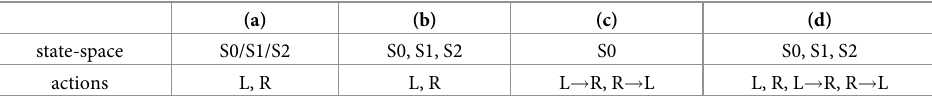
Table 1. Four hypotheses about state-space and action representations. (a) The state-space constitutes a single stage (outcomes such as food pellets are not shown here as states), and ‘L’ and ‘R’ are the only possible actions that the subject considers taking. (b) The state-space matches the correct state-space of the task, and the actions are ‘L’ and ‘R’. (c) The state-space only consists of state S0, and actions are ‘L ! R’ and ‘R ! L’. Note that single actions ‘R’ and ‘L’ are not included. (d) The state-space represents the two stages of the task and actions include both single actions and action